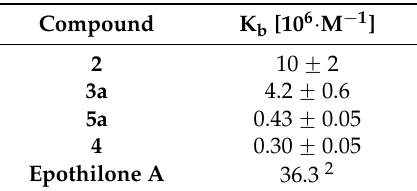
Table 2. Binding constants of azathilones for stabilized microtubules 1